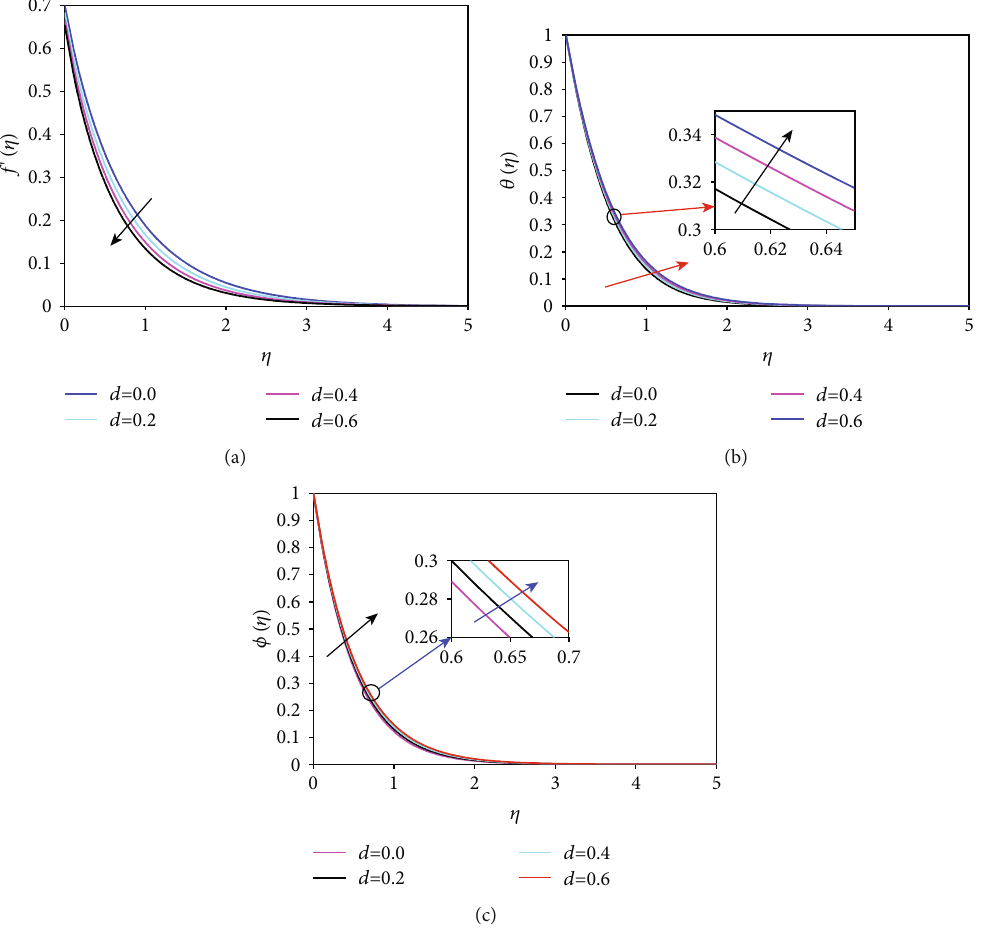
Figure 6: The graph of velocity, temperature, and concentration for di ff erent values of porous parameter ( d